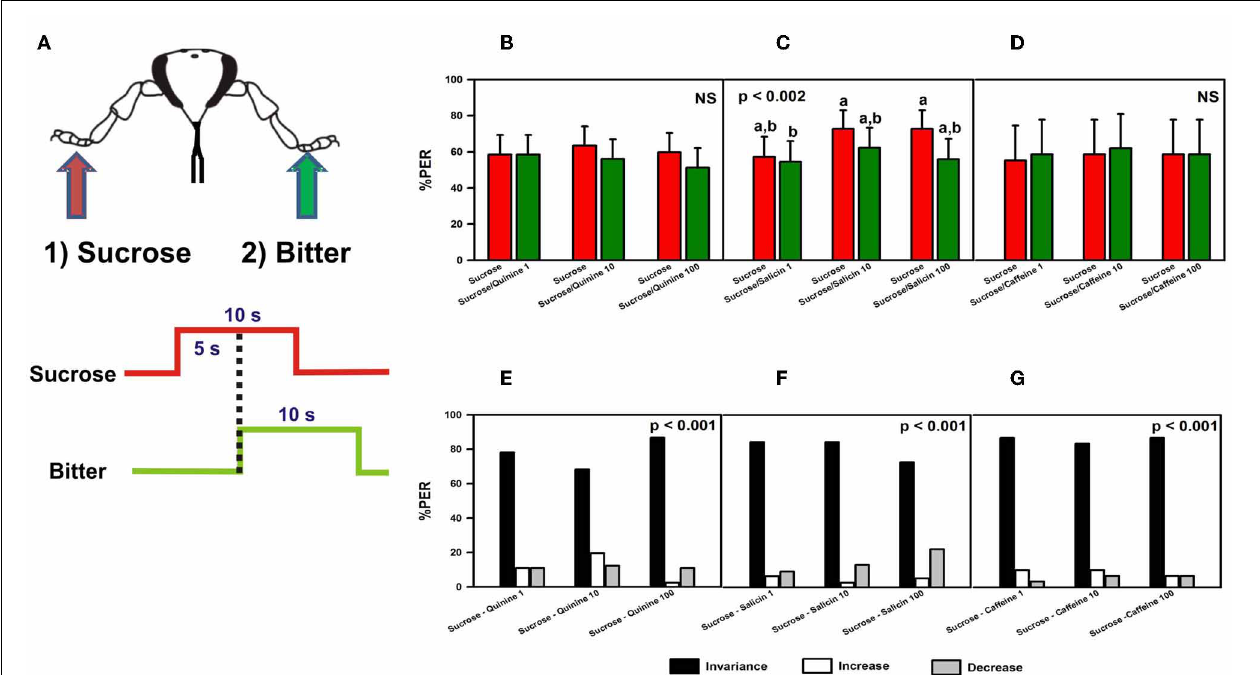
FIGURE 2 | Experiment 1. (A) Bees with amputated antennae were stimulated along three trials with sucrose solution 1M (red arrow; red trace) on one fore-tarsus (either left or right) in order to elicit PER, and 5s later with quinine, salicin, or caffeine (“bitter”, green arrow, green trace) of different concentrations on the contralateral tarsus to determine whether these substances induce proboscis retraction. (B) Percentage of proboscis extension responses (% PER) upon stimulation with sucrose 1M (red bars) and quinine (1, 10, and 100mM; green bars). (C) % PER upon stimulation with sucrose 1M (red bars) and salicin (1, 10, and 100mM; green bars). Different letters above bars indicate significant differences ( p < 0 . 05). (D) % PER upon stimulation with sucrose 1M (red bars) and caffeine